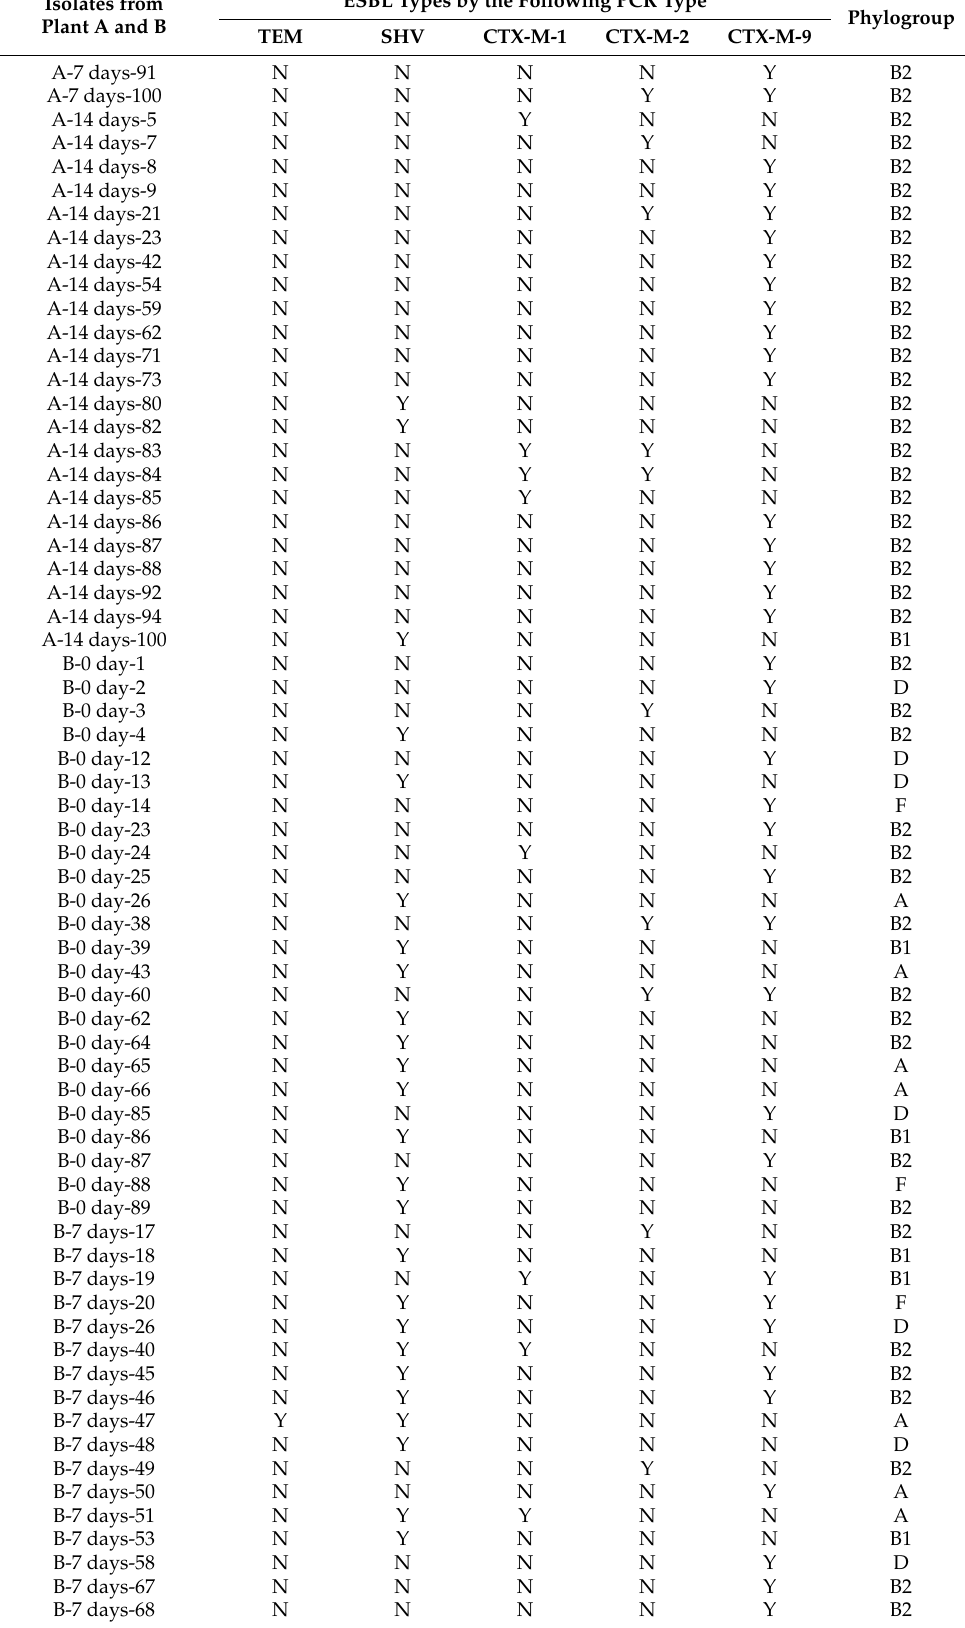
Table 1. The detection of phylogroups and ESBL-producing E. coli isolates. Isolates from Plant A and